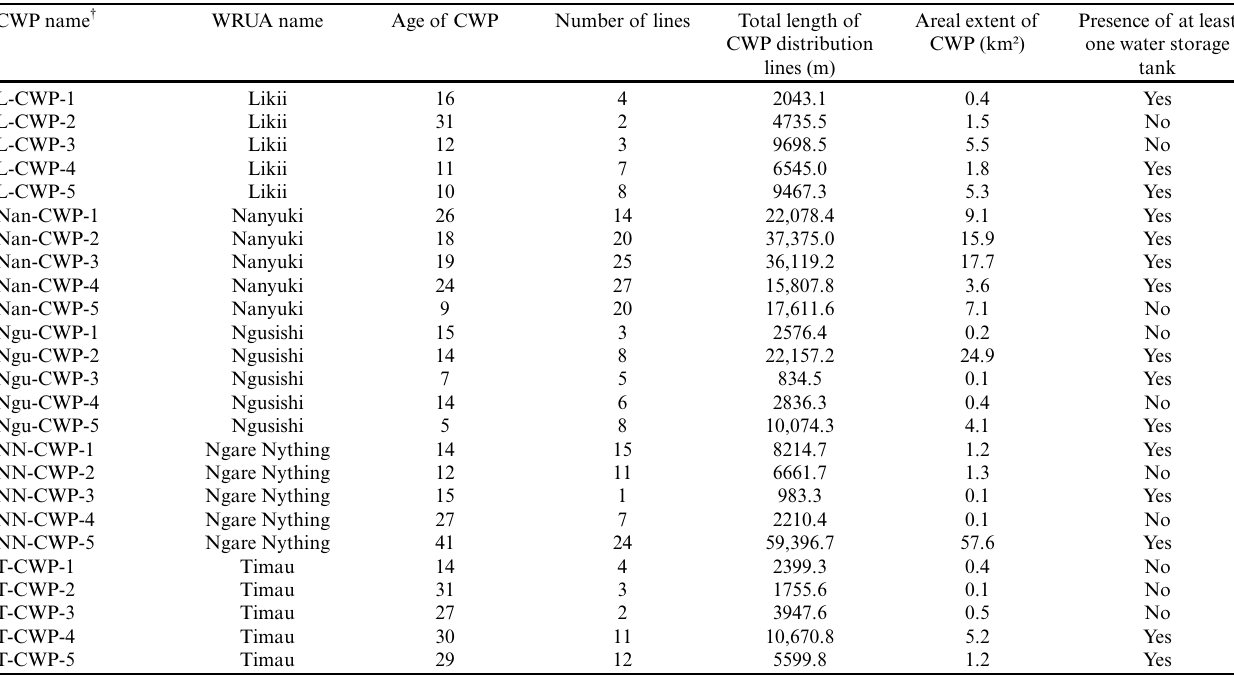
Table 1. Select physical infrastructure attributes of CWPs